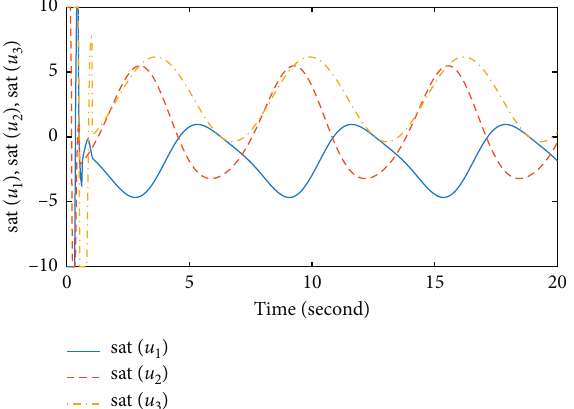
, e ,e by method (21) in time period: (a) [0, 20s]; (b) [10s, 20s]. 1 2 3